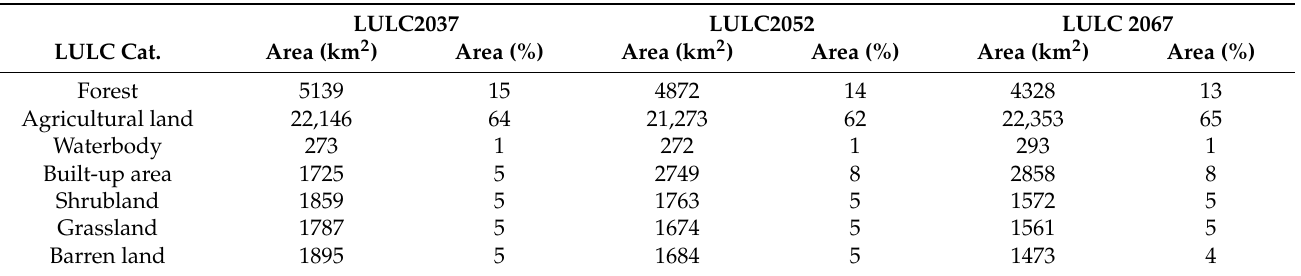
Table 10. Area in km 2 for the LULC (2037, 2052, and